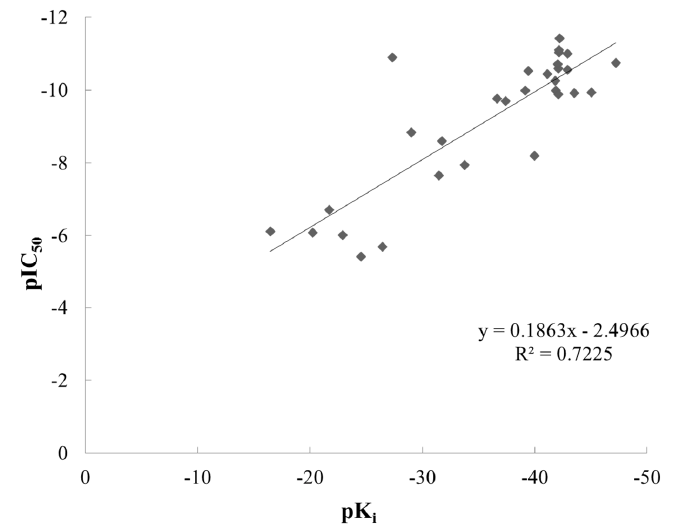
Figure 3. Relationship between the experimental pIC 50 and the calculated pK i of 31 inhibitors ( R 2 = 0.72).